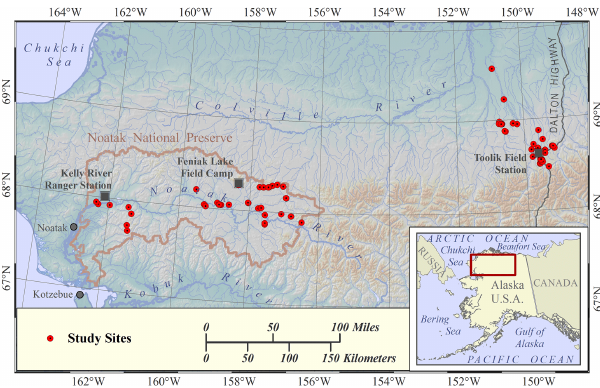
Figure 2. Map of study area. Features near the Kelly River Ranger Station were sampled in July of 2010, near Feniak Lake field camp in July of 2011, and near the Toolik Field Station in the summers of